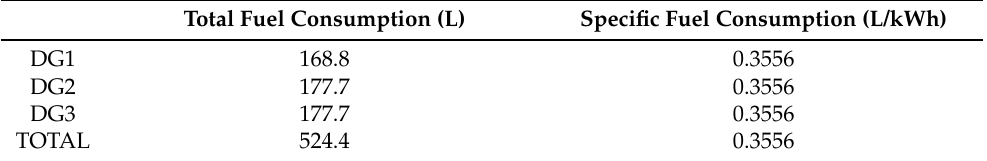
Figure 14. SOC variation and power and BESS injected/absorbed power for off-grid operation (case with PV source outage). Table 7. Total and specific fuel consumption of DG units for off-grid operation (case with PV source